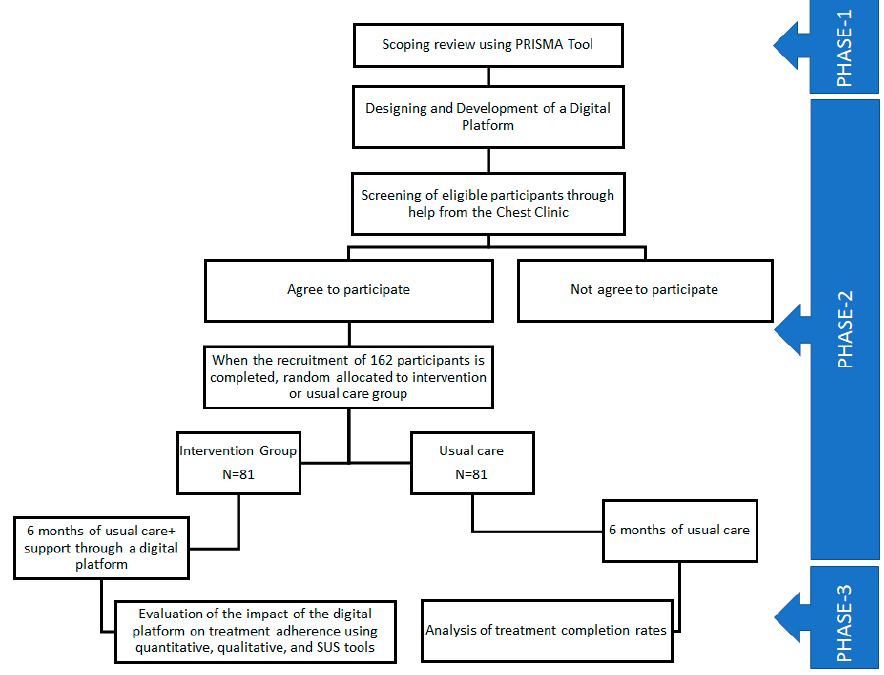
Figure 1. Phases of the study.